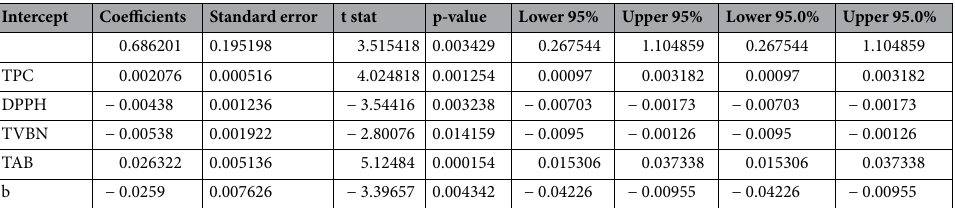
Table 11. Stepwise regression for CPH treated beef nuggets among different